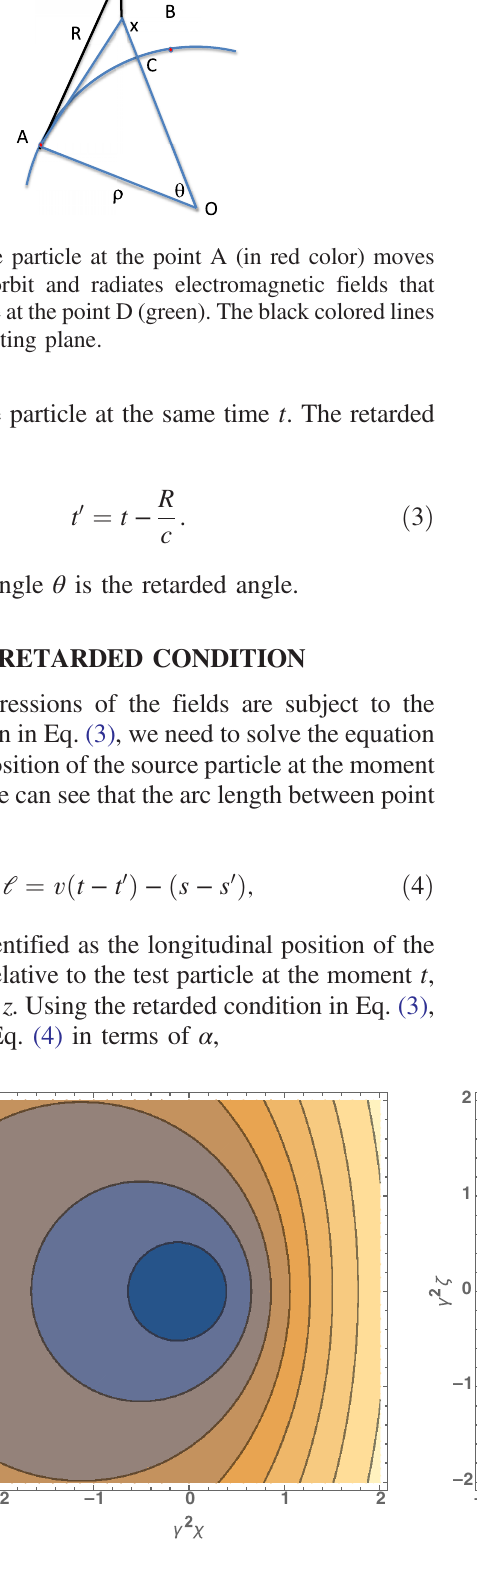
FIG. 2. Comparison of the numerical (left) and analytical (right) solutions of γα as a function of γ 2 χ and γ 2 ζ with ξ ¼ 1 = 300 γ 3 and γ ¼ 500